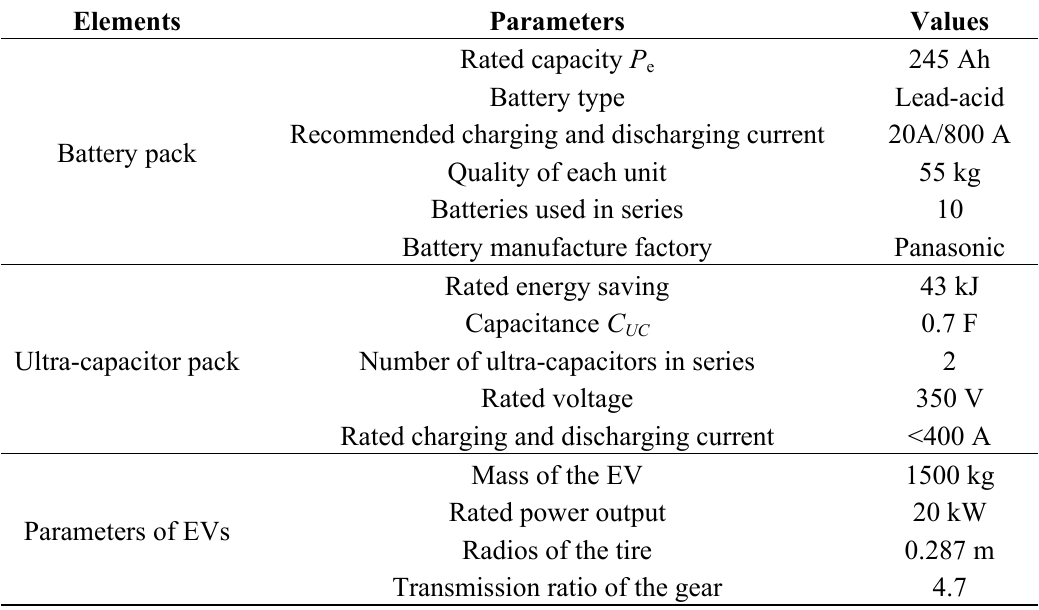
Table A1. Parameters of the hybrid power source system used in